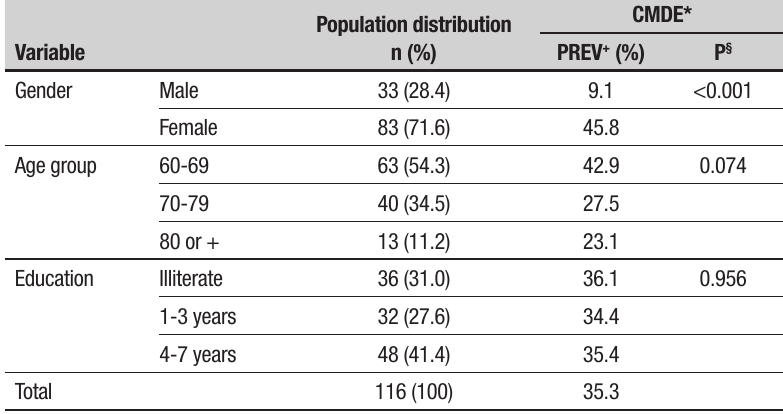
Table 1. Distribution of demographic characteristics and prevalence of current major depressive episode according to the characteristics in 116 elders treated at the reference clinic of a mental health program under the Family Health Strategy in Porto Alegre-RS,